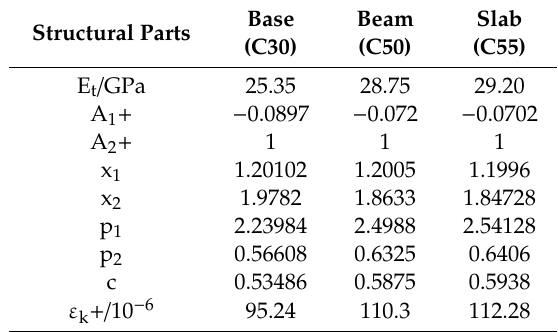
Table 2. Parameters related to the uniaxial tensile constitutive model of the concrete material.